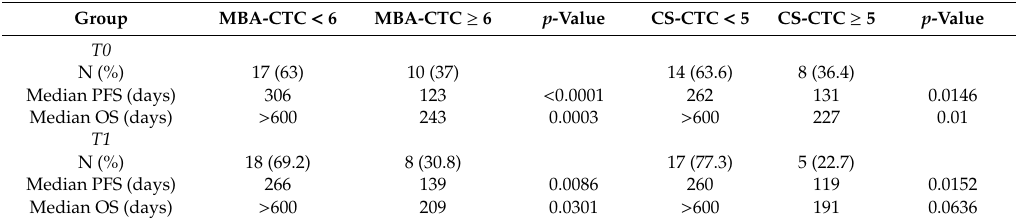
Table 4. PFS and OS by CTC count for metabolism-based assay (MBA) and CellSearch (CS) method at baseline (T0) and follow-up (T1), using respective cut-o ff s.